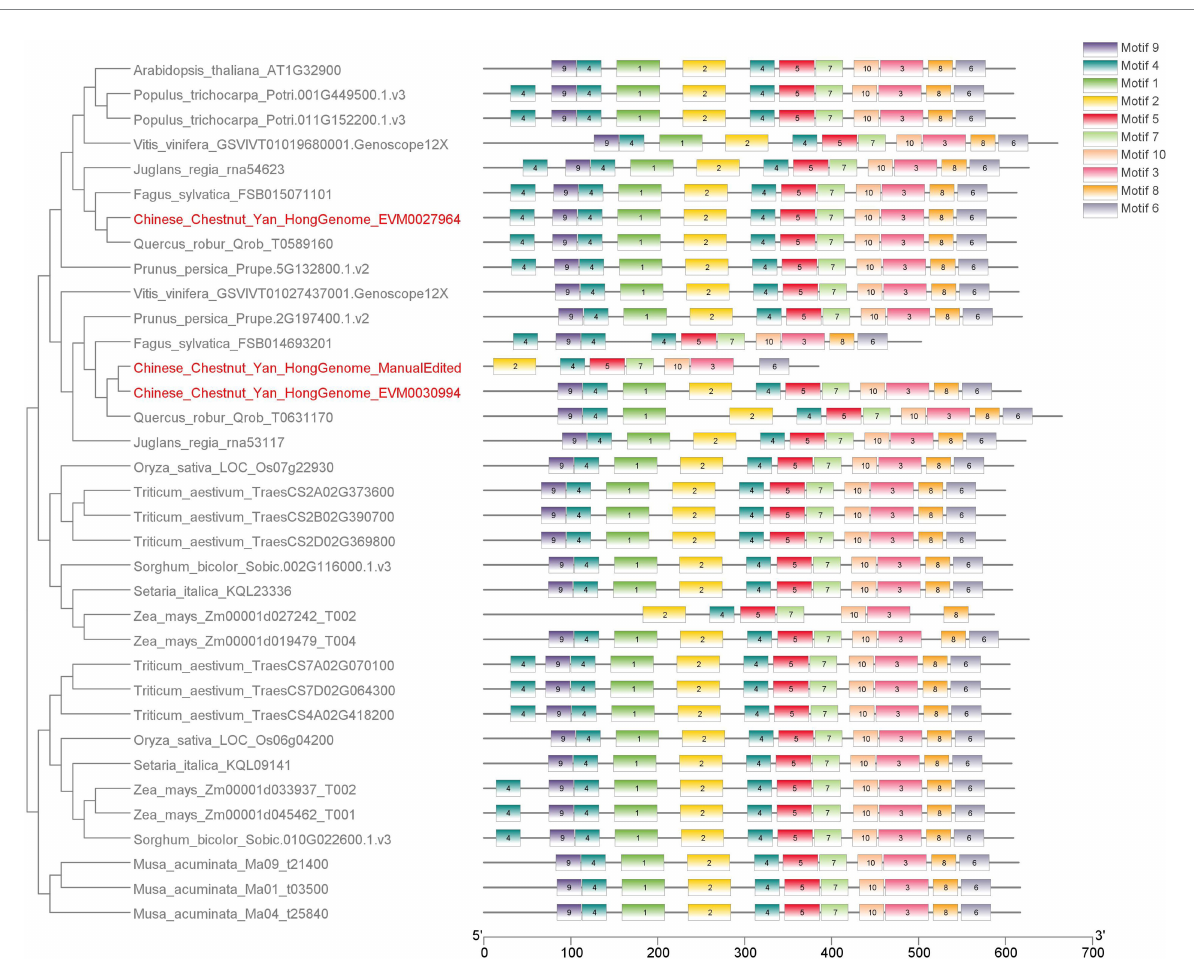
FIGURE 5 Evolution tree and motifs analysis of Chestnut GBSS II family members and 32 orther species. Phylogenetic trees were constructed using IQtree